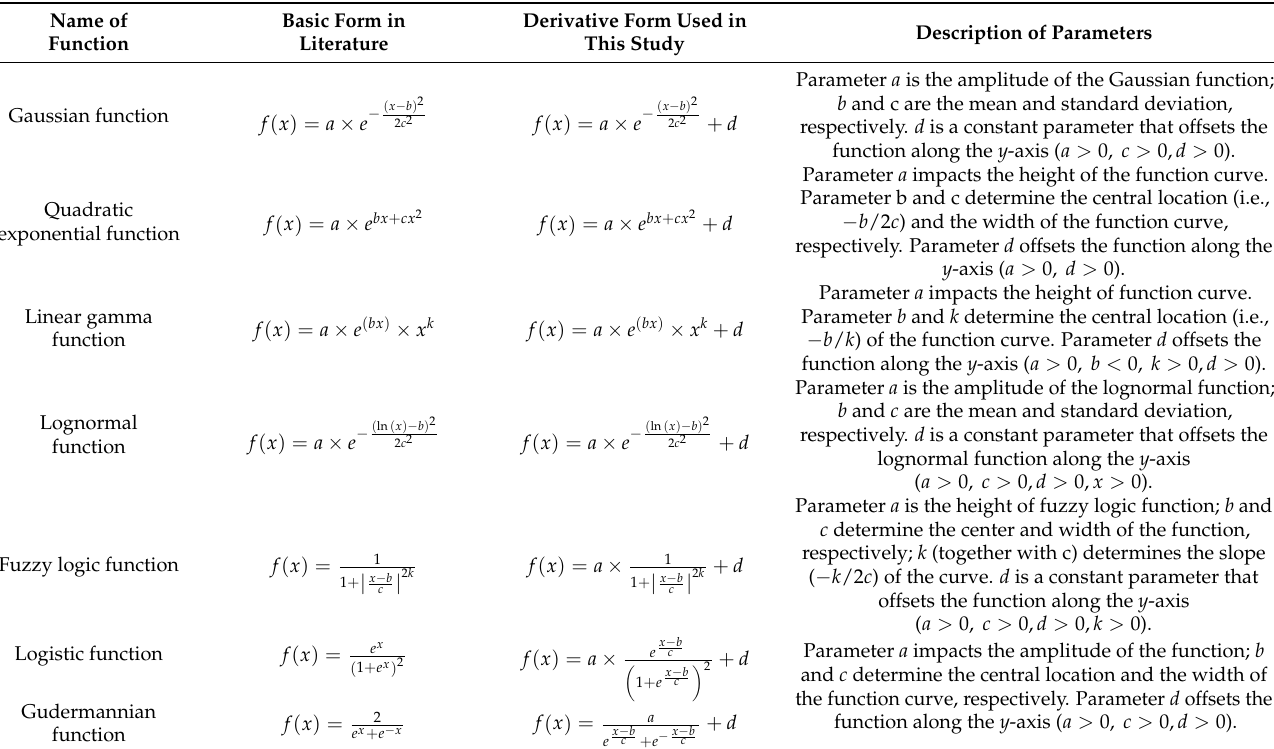
Table 2. Other functions used to fit empirical waves of variations in human activity